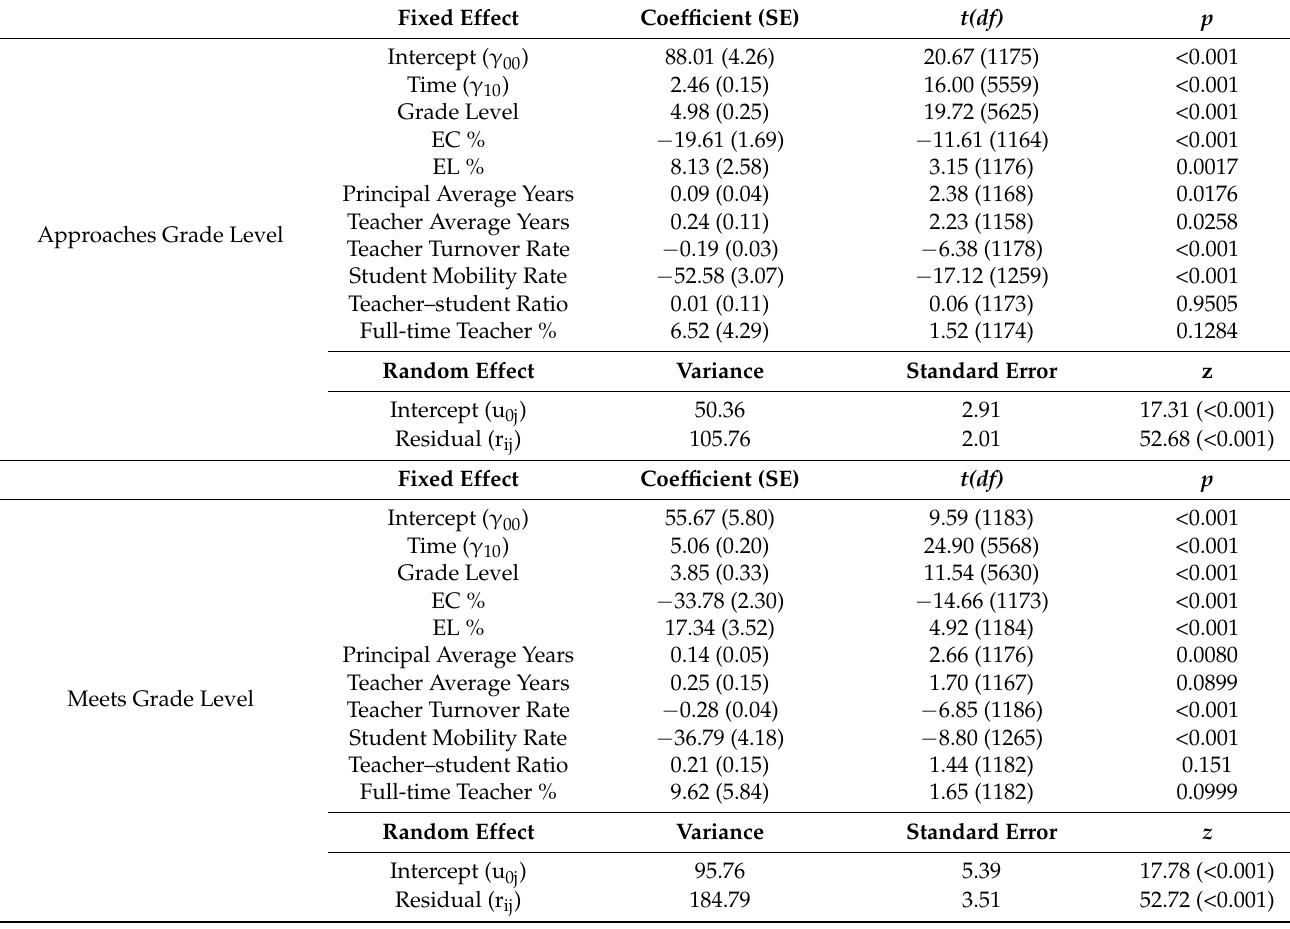
Table 4. Parameter estimates of fixed and random effects of Model 2 by performance